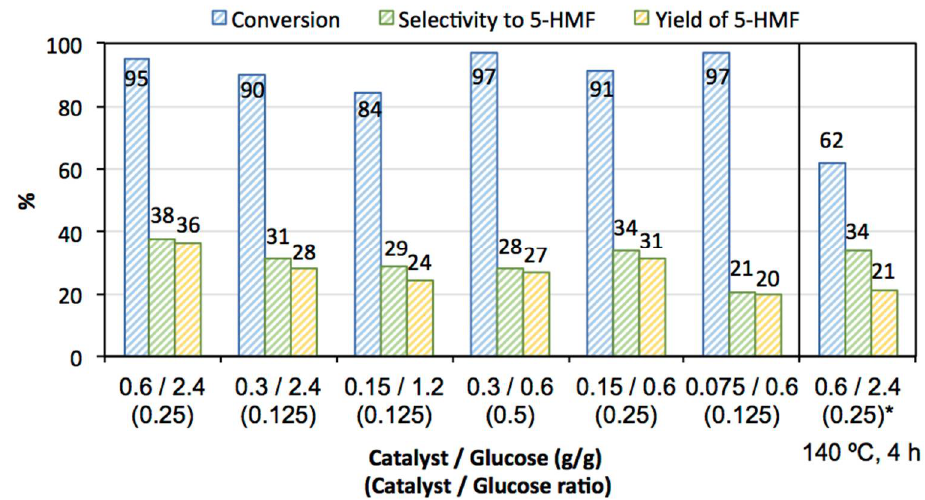
Figure 3. Effect of the different catalyst/glucose wt ratios on the catalytic activity of the catalyst MK10. Reaction conditions: solvent volume ratio (THF:H 2 O) = 35:15, temperature = 180 ◦ C and reaction time = 1 h. * Reaction temperature = 140 ◦ C and Reaction time = 4 h.